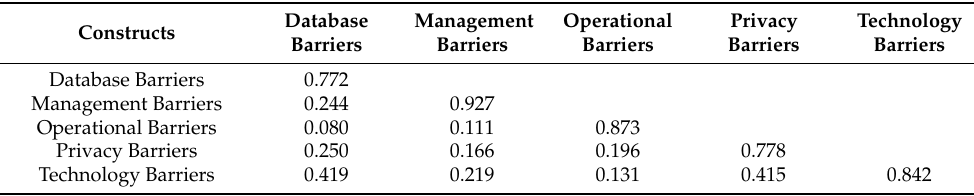
Table 7. HTMT Criterion for discriminant validity.